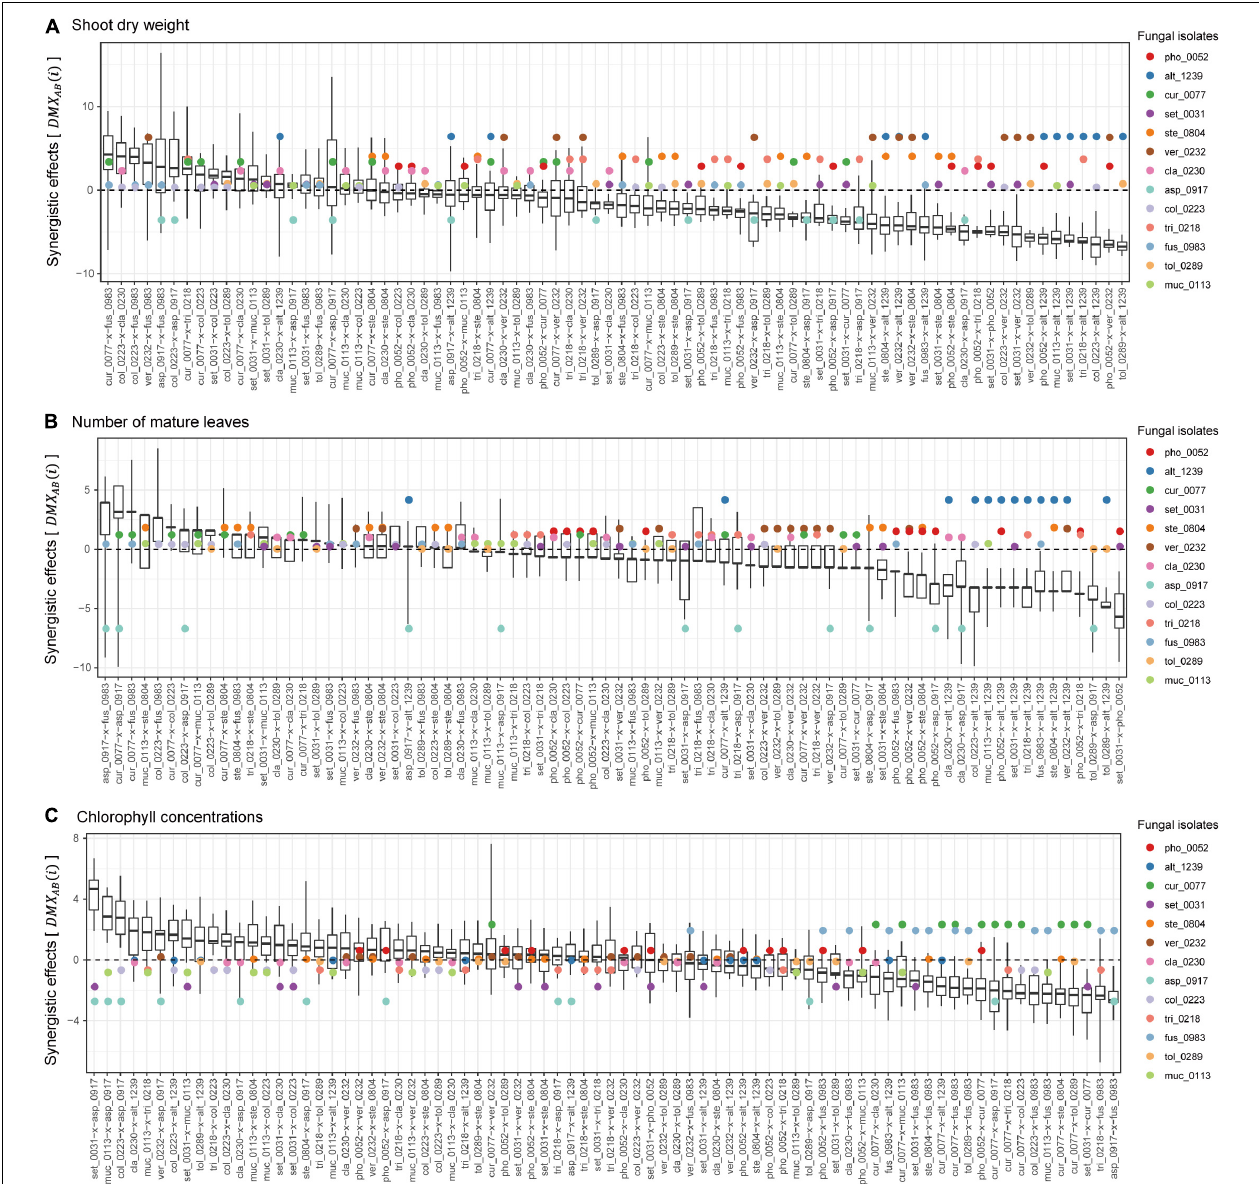
FIGURE 4 | Synergistic effects observed in dual-inoculation experiments. (A) Synergistic effect index in terms of shoot dry weight. The index representing deviation of dual-inoculation effects from the maximum effects in single inoculations are shown for each pair of fungal isolates. Circles represent single-inoculation effects of respective fungal isolates. (B) Synergistic effect index in terms of the number of mature leaves. (C) Synergistic effect index in terms of chlorophyll